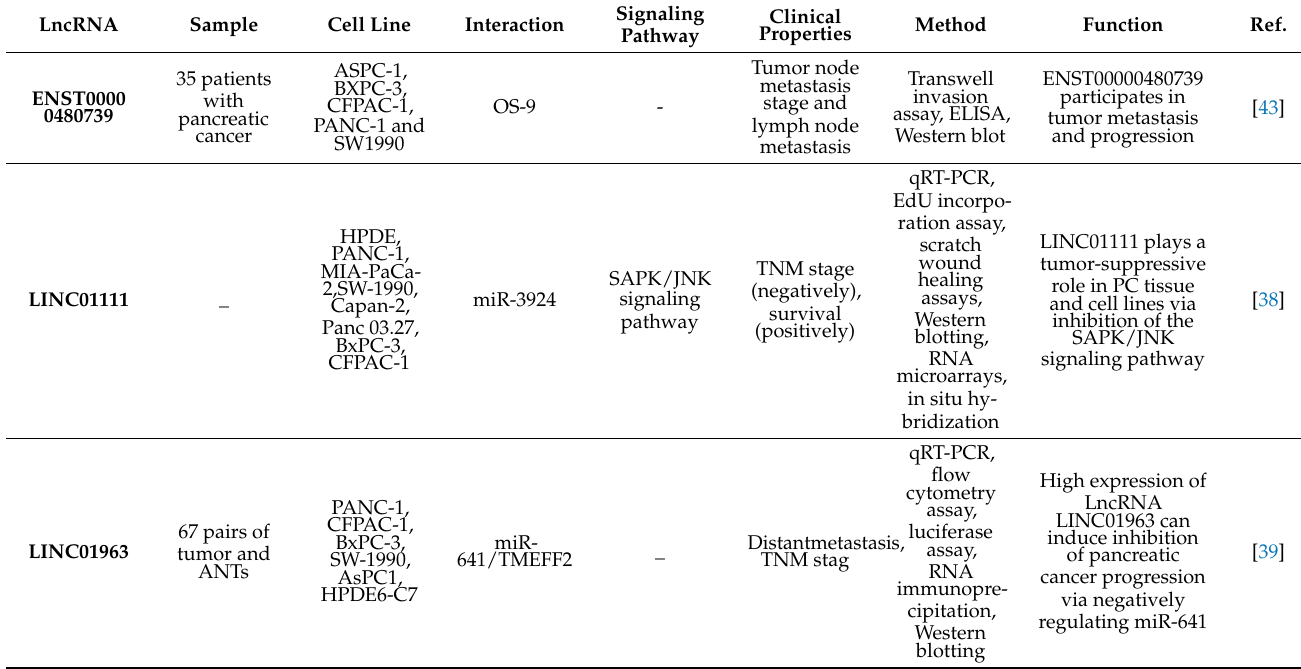
Table 2. List of down-regulated lncRNAs in pancreatic cancer (ANTs: adjacent non-cancerous tissue).